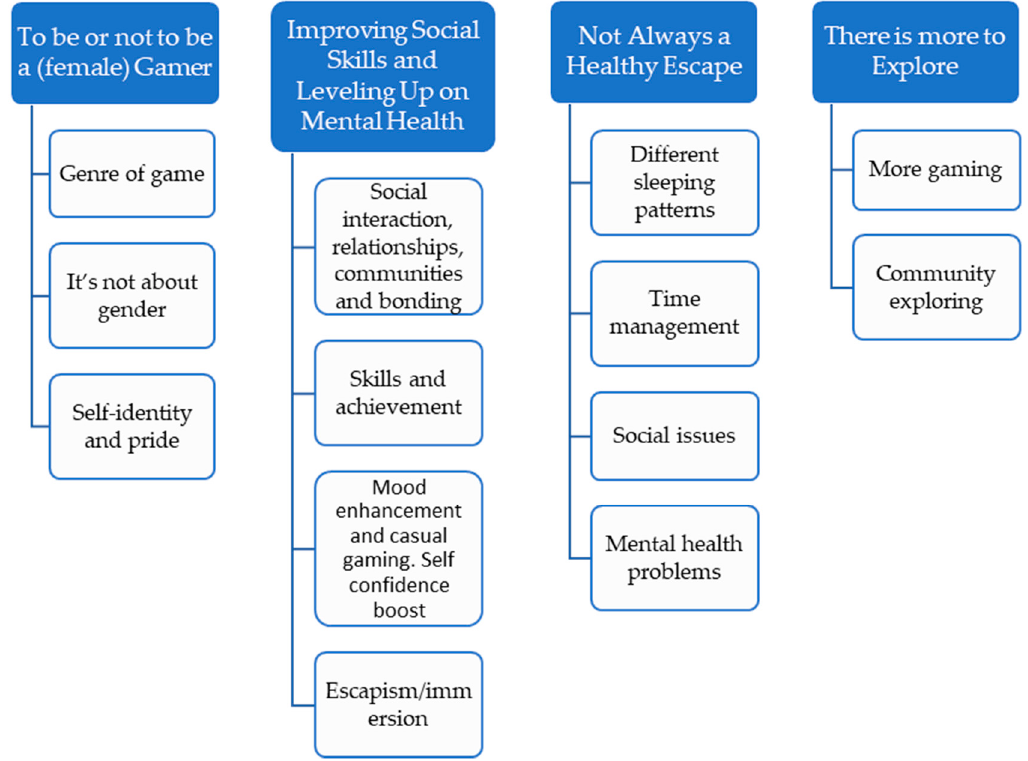
Figure 1. Overview of identified themes and subthemes.